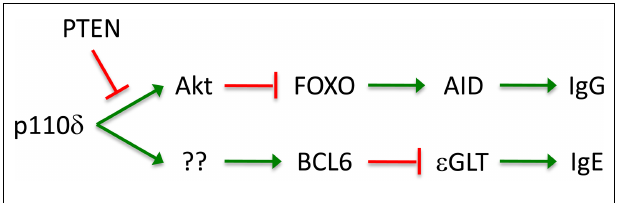
FIGURE 3 | Role of the PI3K pathway in Ig isotype switch. The figure depicts the regulatory linkages through which PI3K impacts on Ig isotype switch to IgG and IgE. PI3K-dependent activation of Akt leads to phosphorylation and inactivation of FOXO transcription factors, which drive expression of AID, an enzyme required for all isotype switch. PI3K-dependent, Akt-independent enhancement of BCL6 expression (through an unknown mechanism) promotes the GC B cell gene expression program and also suppresses germline transcription of the IgE locus (eGLT), selectively repressing switch to